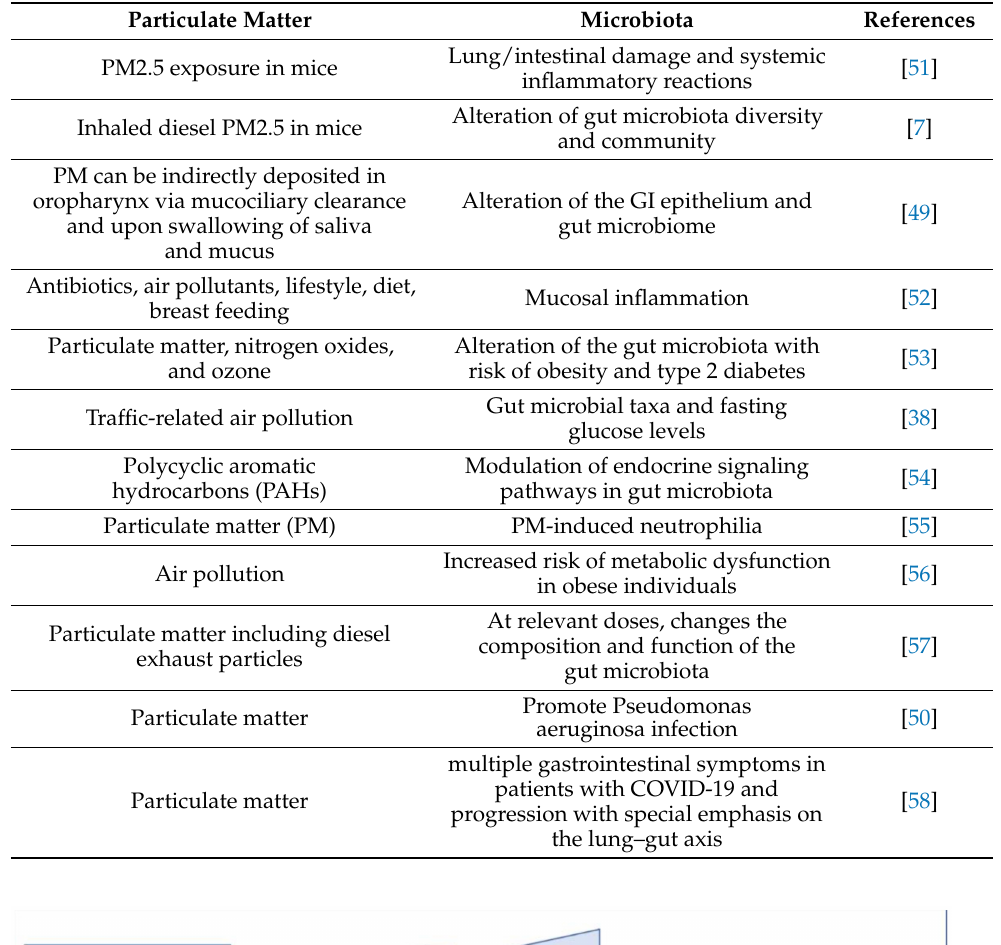
Table 1. An overview of studies focused on associations between particulate matter, gut, and lung microbiota alteration.